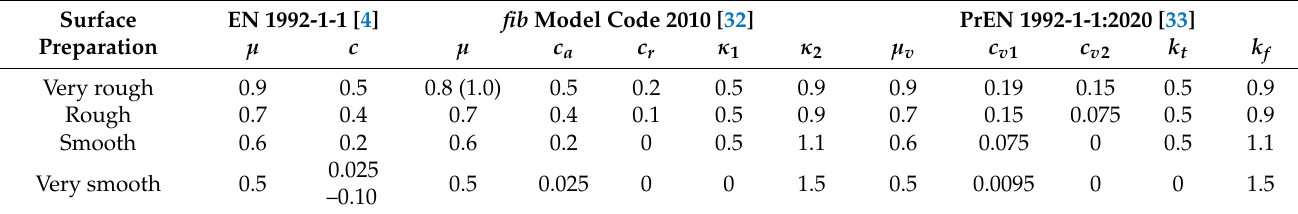
Table 2. Coefficients depending on the surface